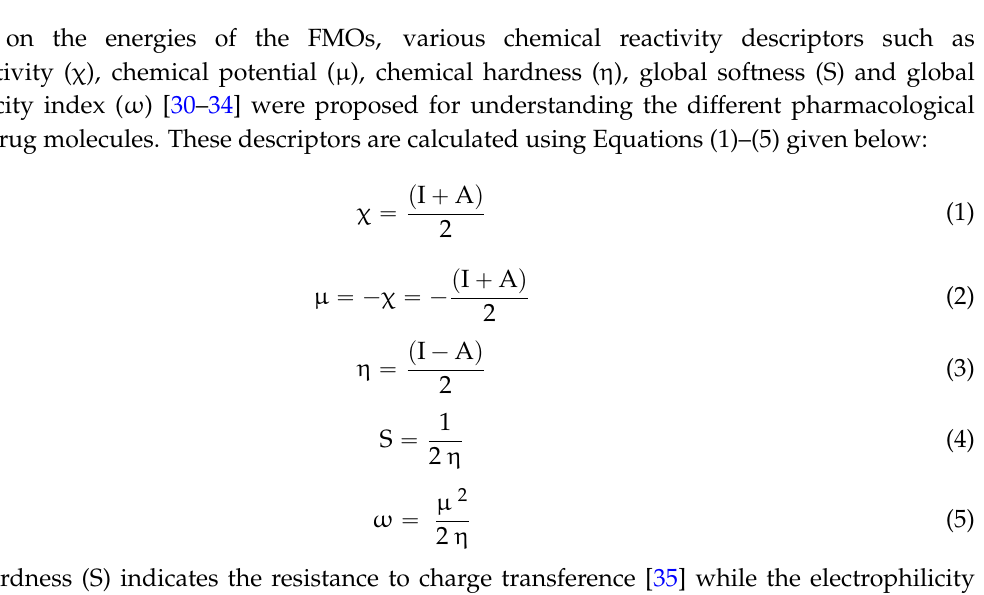
Figure 4. Ground state isodensity surface plots for the frontier molecular orbitals.